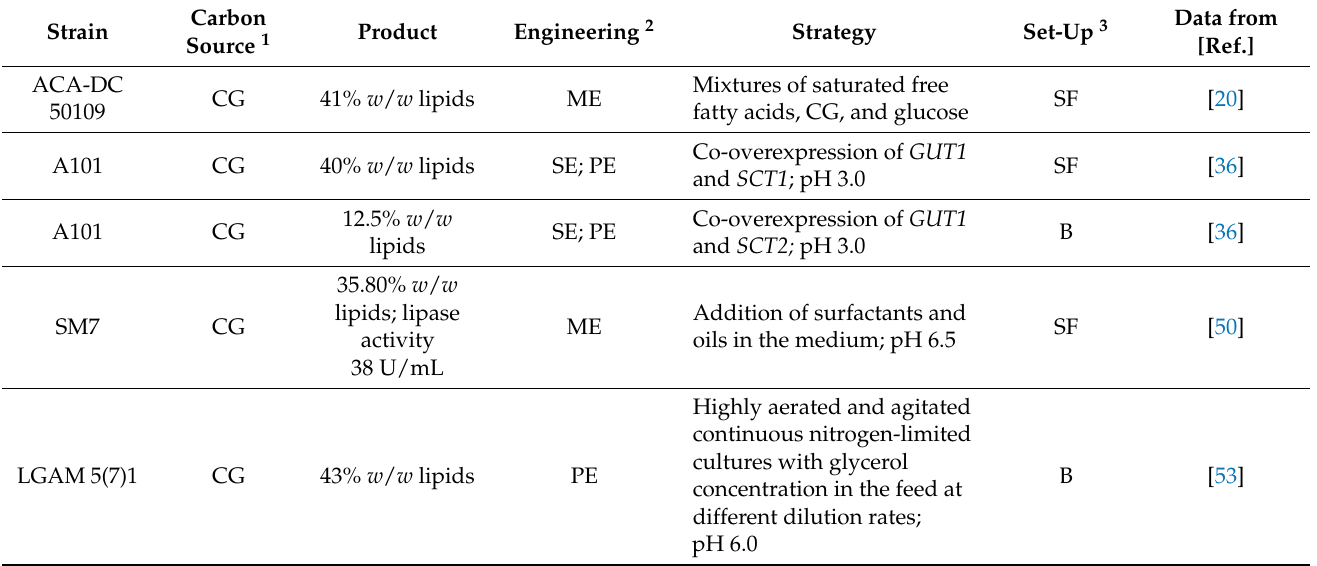
Table 1. Engineering strategies (strain, medium, process) and cultivation systems using pure or crude glycerol as carbon source for the production of lipids by Y. lipolytica